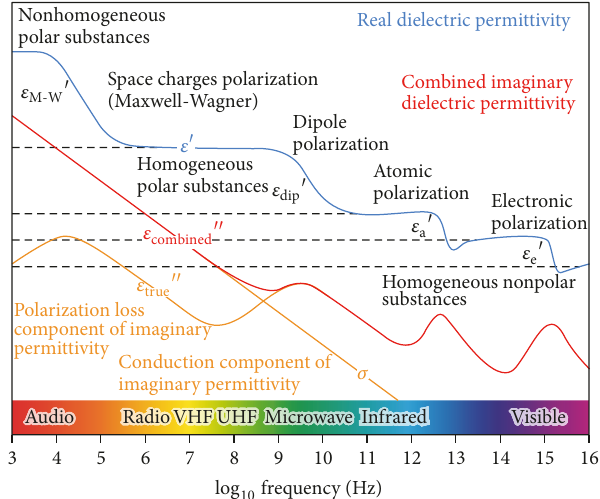
Figure 1: Schematics of dielectric polarization/conduction mecha- nisms, modified from Josh